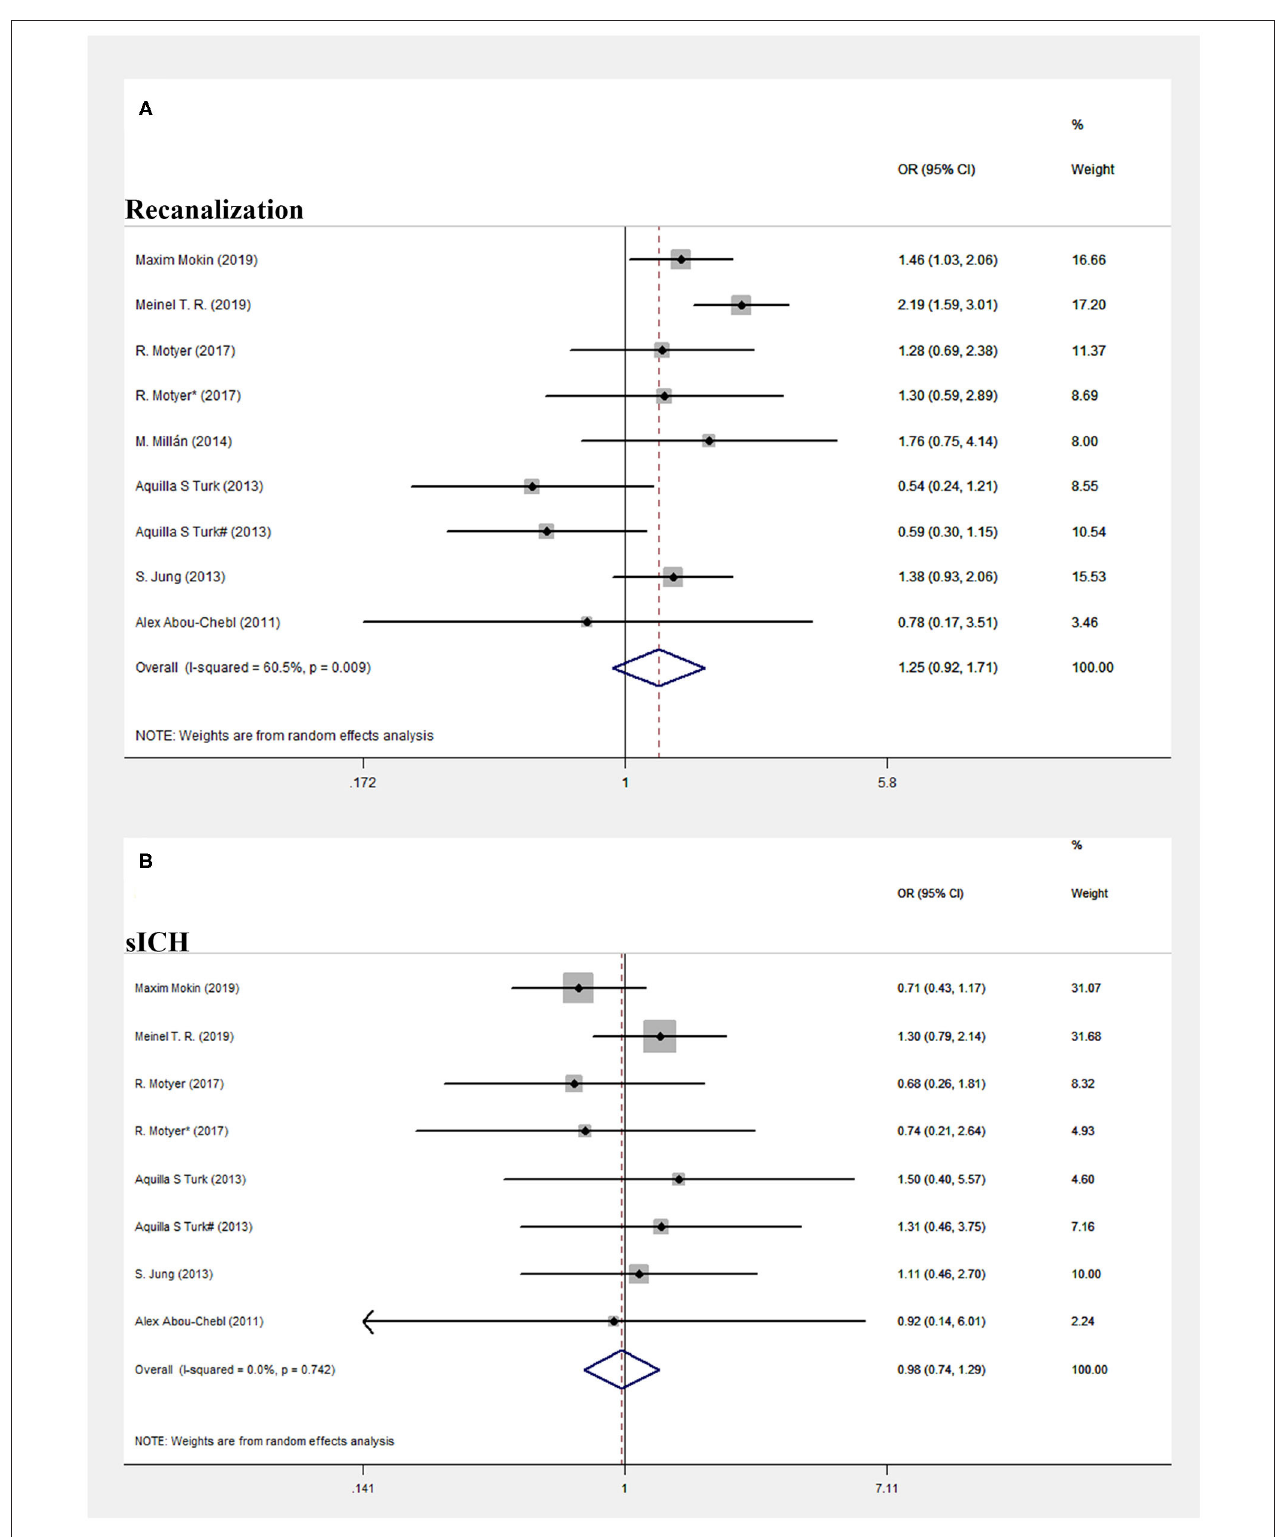
FIGURE 3 | Forest plot of comparison. (A) Successful recanalization. (B) Systematic intracranial hemorrhage.